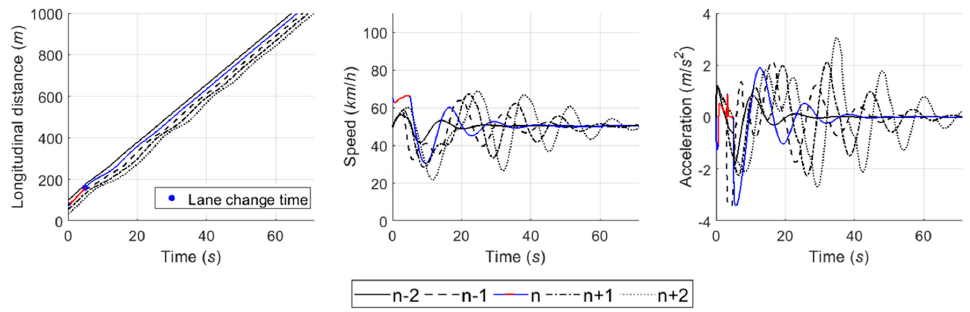
Figure 20. Graphical representation of simulation results in case 3. Note that a red solid line indicates simulation data of the SV (vehicle n ) during game period, whereas a blue solid line shows the SV’s data in simulation time except game